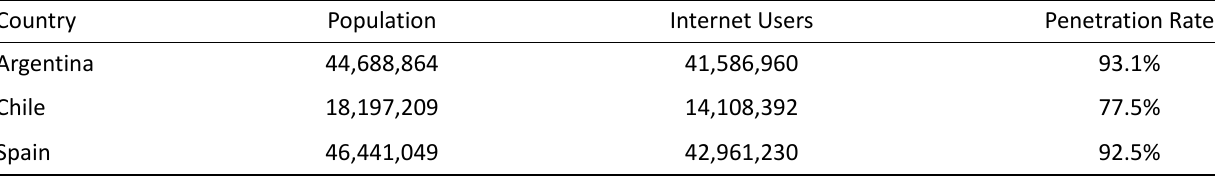
Table 1. Penetration of the Internet in analysed countries. Country